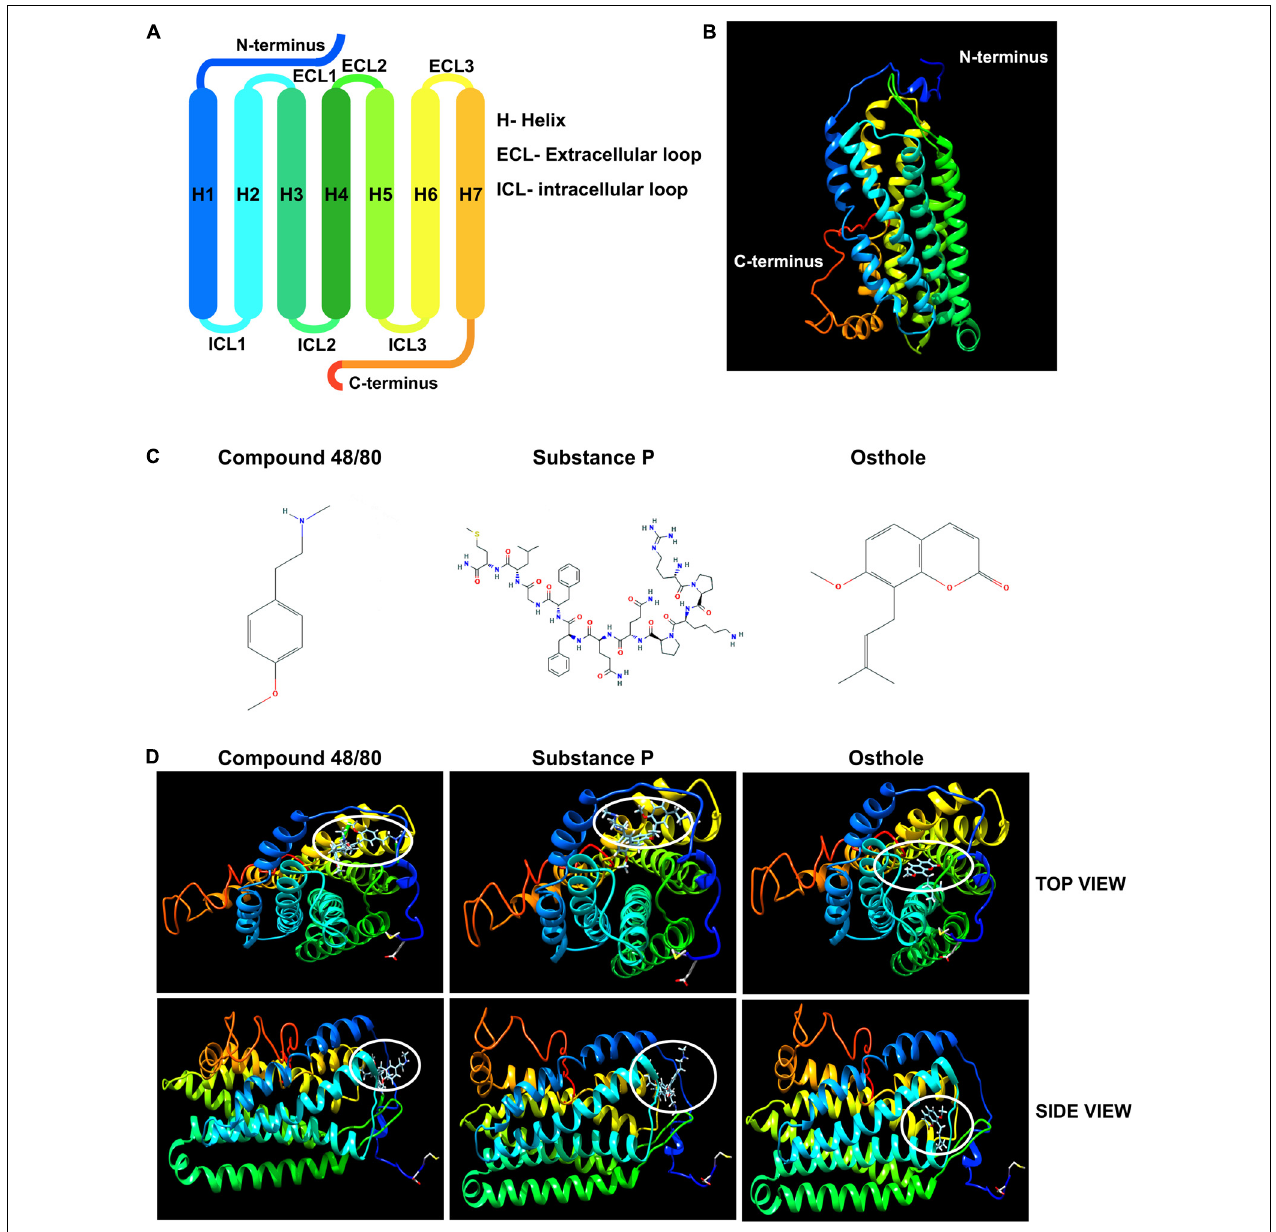
FIGURE 7 | Molecular docking studies of osthole and MRGPRX2. (A) Labeled schematic of the MRGPRX2 receptor including the seven transmembrane helices (H), extracellular (ECL) and intracellular (ICL) loops, and the N- and C-termini is shown. (B) Predicted molecular model of native MRGPRX2 and (C) chemical structures of compound 48/80, substance P and osthole are shown. (D) Top view and side view of predicted molecular docking of compound 48/80, substance P and osthole with MRGPRX2 are shown. The region where the ligands or osthole are predicted to interact with the receptor is encircled (white